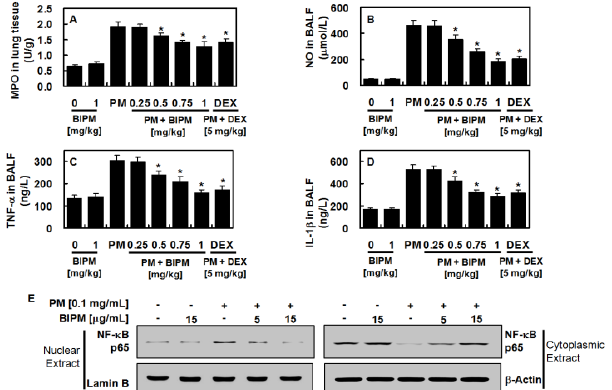
Figure 5. Effects of BIPM on PM-induced pulmonary inflammation. The BIPM and DEX groups were injected intravenously 30 min after being intratracheally challenged with PM 2.5 (10 mg / kg in 50 µ L of saline). The mice were then sacrificed 24 h post-PM-injection, and the lung tissue and BALF were harvested. ( A ) myeloperoxidase (MPO) in lung tissue, ( B ) nitrous oxide (NO), ( C ) TNF- α , and ( D ) IL-1 β in the BALF were measured. ( E ) The expression levels of NF- κ B in nuclear and cytoplasmic extracts were evaluated with Western blot analyses; actin and lamin B were used as loading controls for the cytoplasmic and nuclear extracts, respectively. The values represent the mean ± SD of three independent experiments. * p < 0.01 versus the PM-challenged